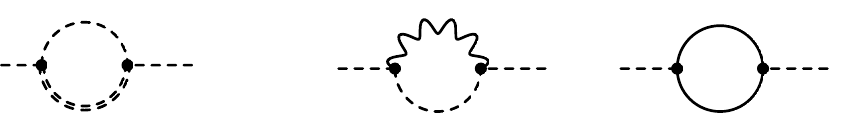
Figure 3 . Higgs wave function renormalisation e(cid:11)ects. Left: heavy-light contribution to Z (1) in (3.8). Right: gauge-boson and fermionic contributions to the anomalous dimensions of the SSM parameters A and (cid:20) in (B.3) and (B.4). The wiggly line corresponds to a B (cid:22) or W a solid straight lines represent fermion (cid:12)elds, while the rest of the line styles and their meanings are identical to those employed in (cid:12)gure 1.